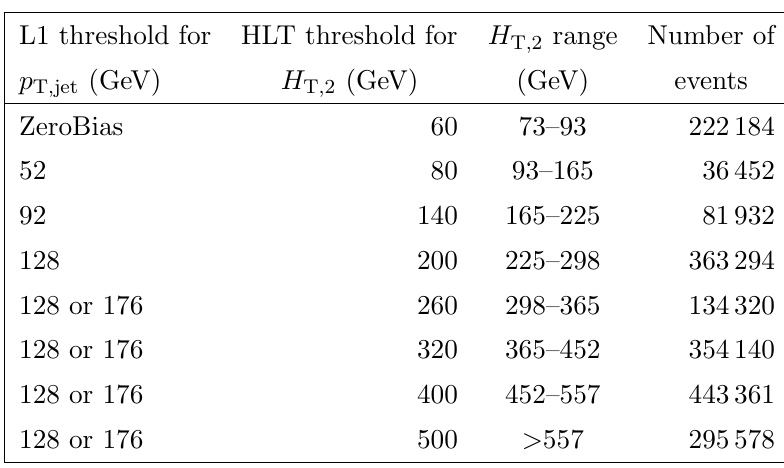
Table 1 . L1 trigger thresholds, HLT thresholds, H T ; 2 range and number of events used in the